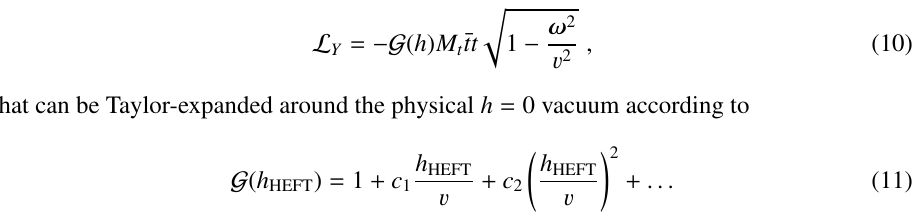
Figure 2. The correlation v 4 = v − 5 − 1 Δ a 3 3 1 that SMEFT pre- 2 4 6 dicts at O (1 / Λ 2 ), from the 95% confidence interval for v 3 ∈ [ − 2 . 5 , 5 . 7] [17]. The experi- mental a 1 uncertainty [16, 19], a 1 ∈ [0 . 97 , 1 . 09], is numeri- 2 cally negligible and allows to predict the (solid, diagonal) SMEFT band. An experimen- tal measurement of v 4 is nec- essary to test this, by adding a horizontal band to the plot.